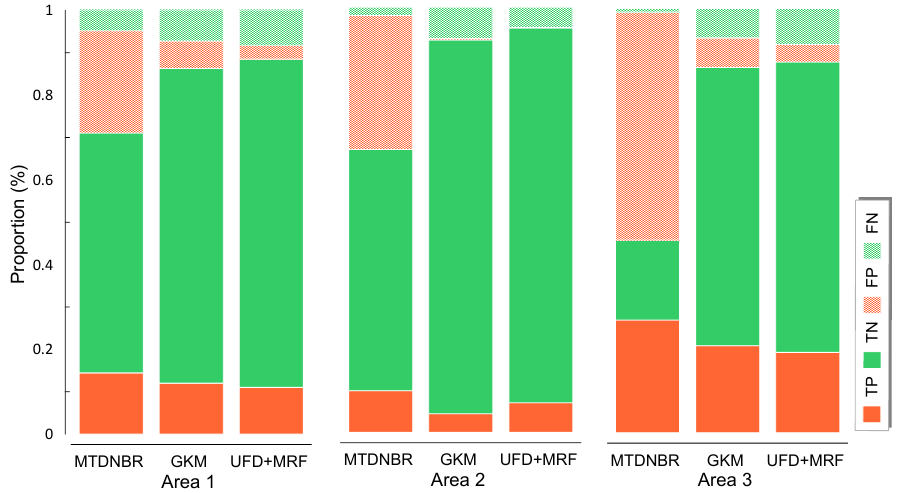
Figure 13. True/false positive/negative detection